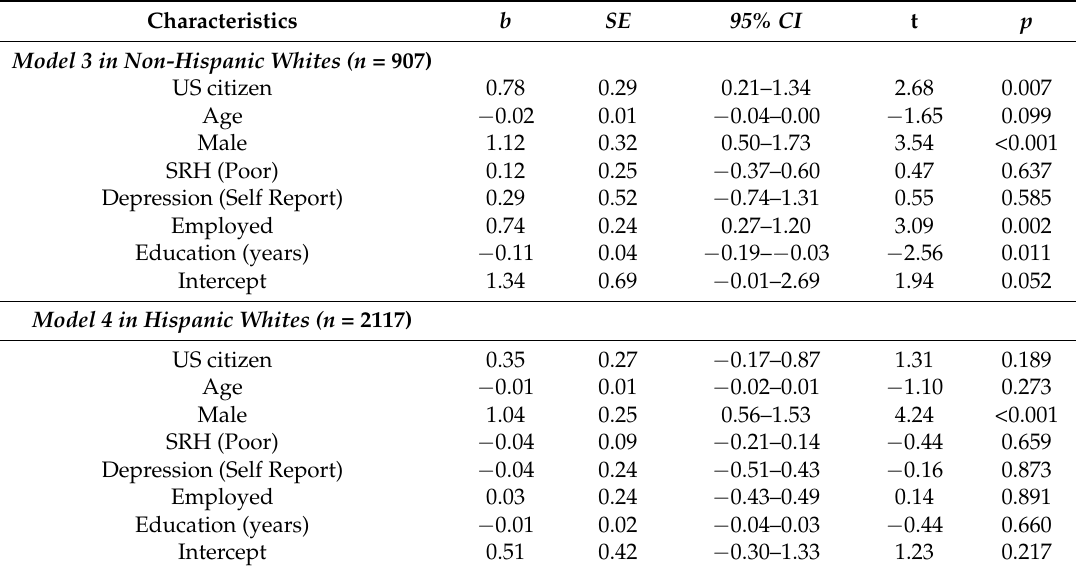
Table 4. Results of two linear regression models by